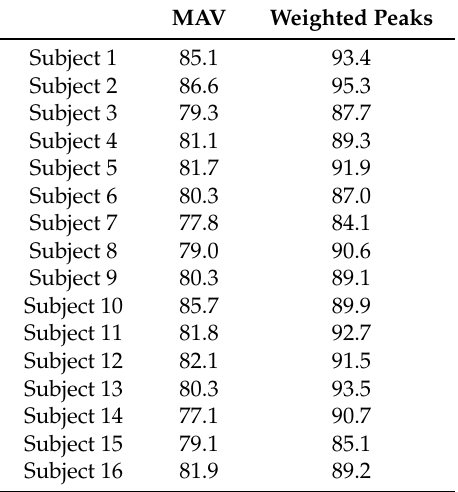
Figure 14. Example of a scatter figure on IEMG signals and a sEMG trend with weighted peaks in node 4.0. Table 1. Average recognition rate of contrastive experimental results (%).